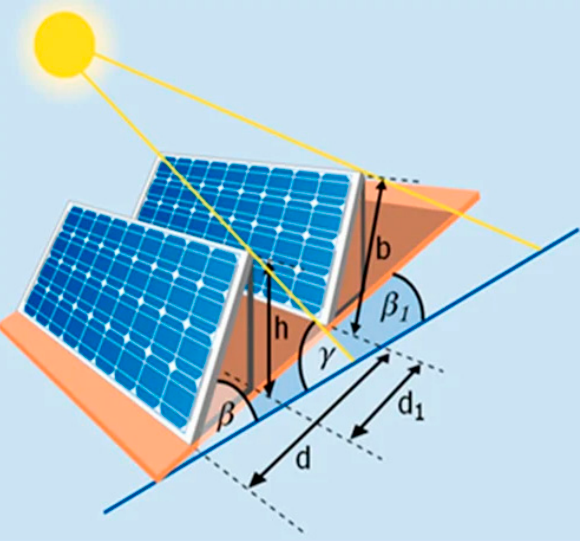
Figure 3. Solar angles, tilt angles and distance between arrays (as calculated by the PV*SOL program).